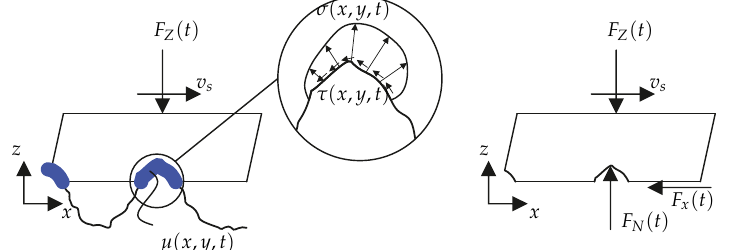
Figure 3. Representation of the contact between tread block and rough road surface. The thick blue line represents the area of the viscous water film, µ ( x , y , t ) the time and location dependent coefficient of friction prevailing in the